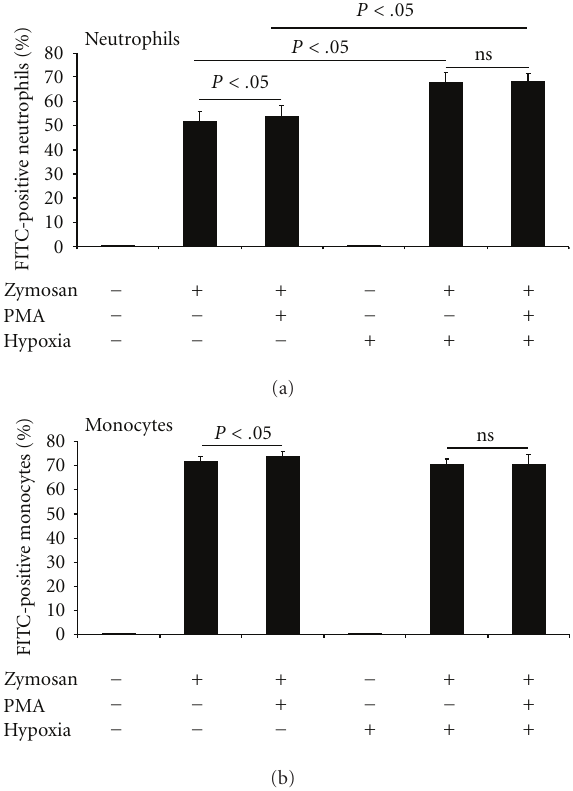
Figure 2: Phagocytic activity of neutrophils and monocytes. Neu- trophils or monocytes under normoxia or hypoxia unstimulated or stimulated with PMA were examined. Data are shown as mean ± SEM; n = 14.